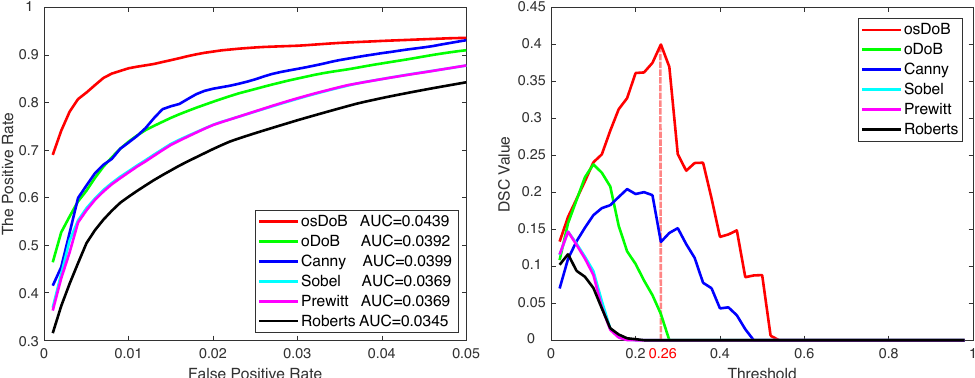
Figure 14. The quantitative comparison